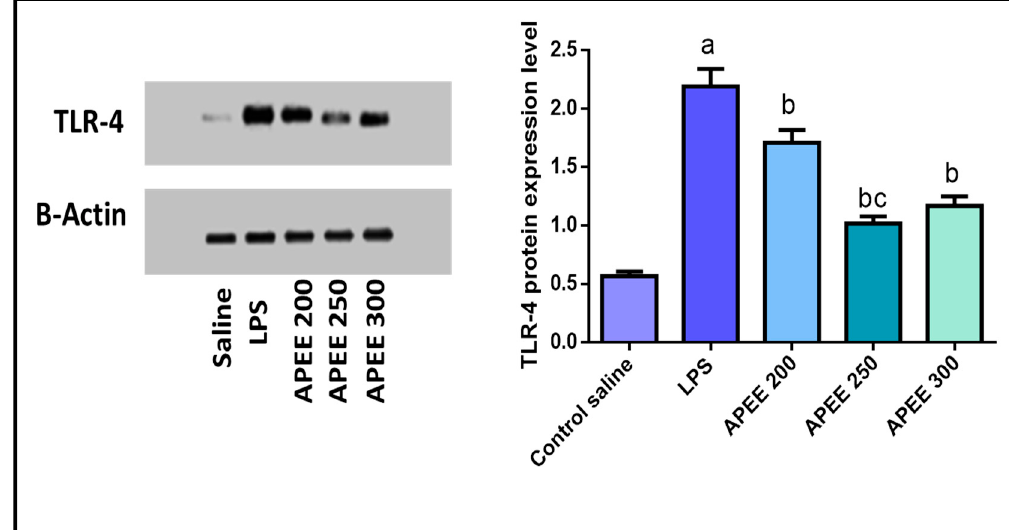
Figure 8. Effect of APEE pre-treatment on the expression of TLR-4 in the lung tissues. The expression levels were measured by western blotting. Acute lung injury was urged by I.P. injection of LPS (10 mg/kg). APEE 200, 250, and 300 were given I.P. 30 min before LPS injection. Results were expressed as mean ± SD ( n = 10/group) as the experiments were performed in three independent triplicates. Significant difference vs. a respective control, b respective LPS group, c respective APEE 200 group each at p < 0.05.